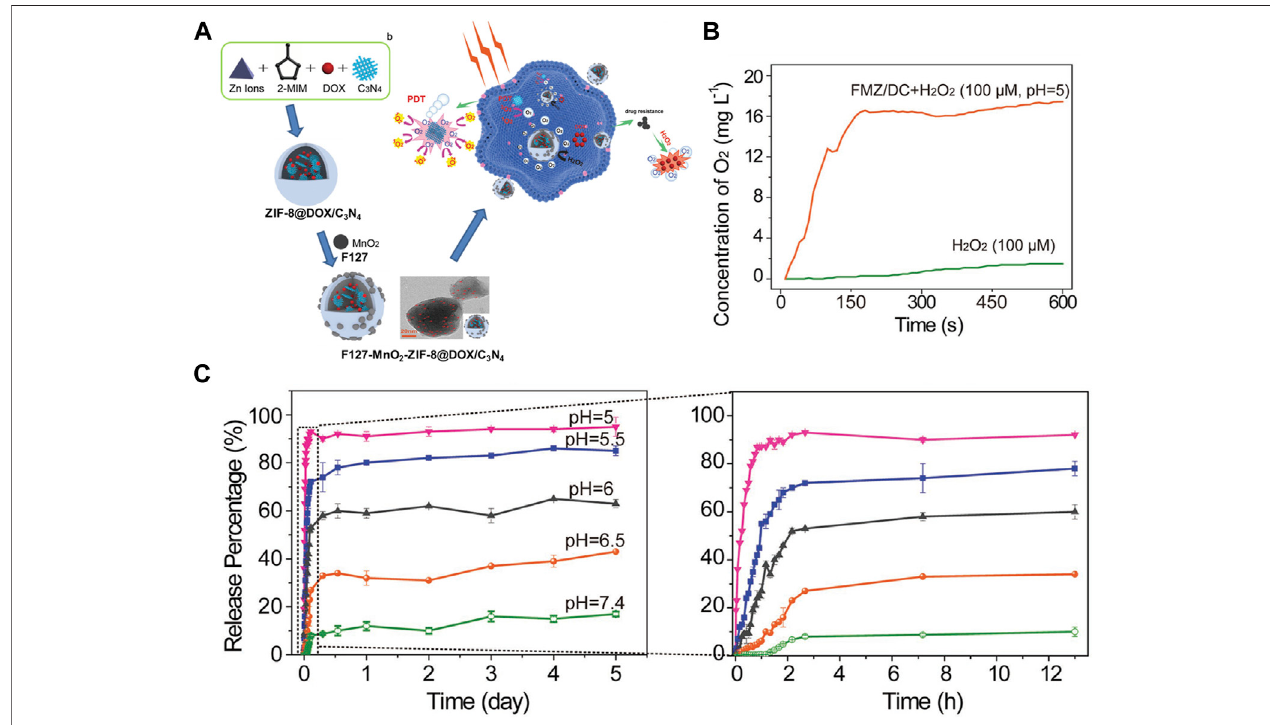
FIGURE 7 | (A) The schematic illustration of the fabrication of F127-MnO 2 -ZIF@DOX/C 3 N 4 and F127-MnO 2 -ZIF@DOX/C 3 N 4 with 1 O 2 generation enhancing the chemo-photodynamic therapy. (B) In vitro evaluation of 1 O 2 generation ofFMZ/DC in H 2 O 2 solution (10 – 4 m) under pH (cid:1) 5. (C) The pH-responsive release ofDOX from FMZ/DC determined by UV – vis spectrophotometry. Source: (Xu et al., 2017).